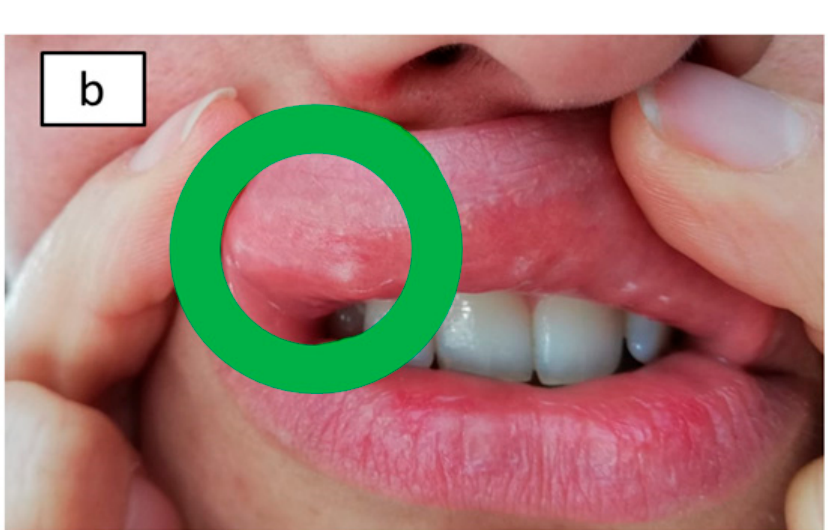
Figure 3. Nickel oral mucosa patch test (Ni omPT) results: Ni-sensitive patients before Ni omPT application ( a ) and after Ni omPT removal (2 h) ( b ).